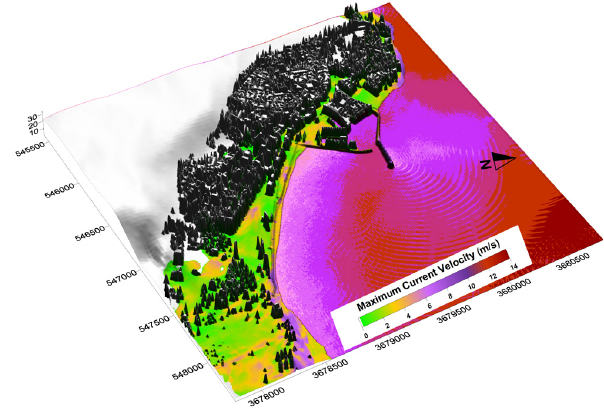
Fig. 10. Overland inundation map for El Jadida-site considering the M w = 8 . 5 HS scenario.